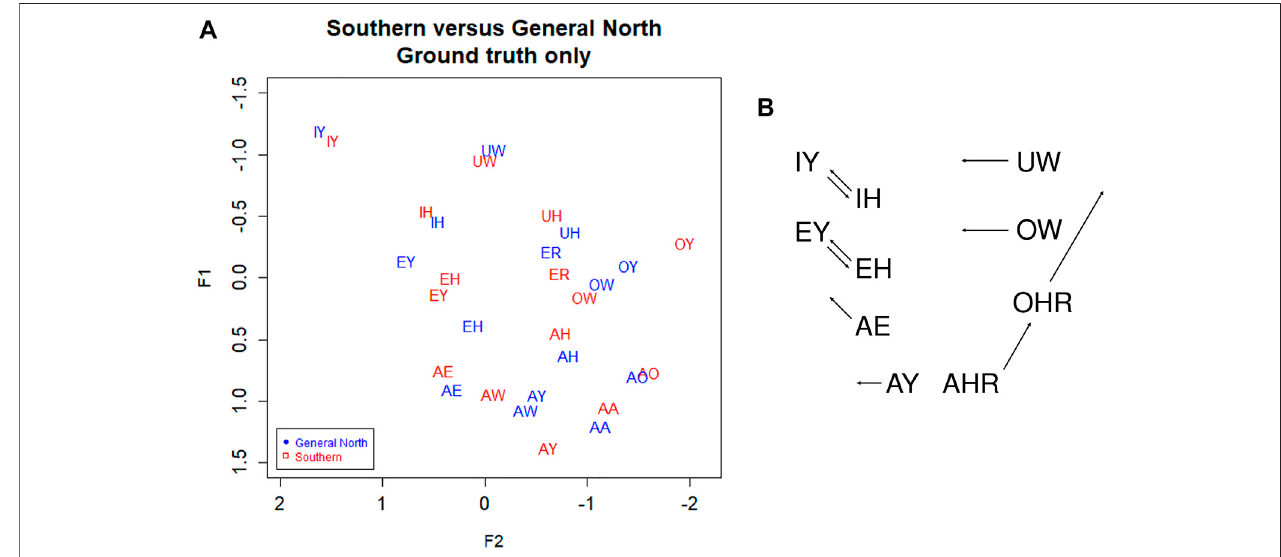
FIGURE 3 | (A) Southern versus General North data from manual transcription: Red (cid:1) South, Blue (cid:1) North. Ground truth (manual transcription). Speaker vowel means. 330 speakers, 31,900 tokens. Plotted in Lobanov-normalized units. (B) Abstract schematic of the Southern Vowel Shift (adapted from Labov,